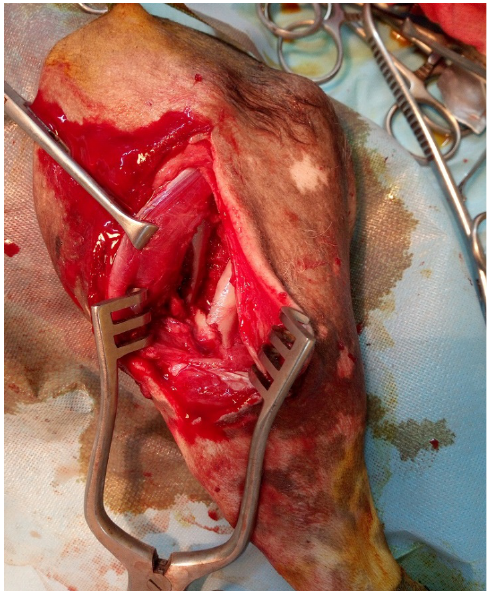
Fig. 2. Multiple fracture with 3 segments of femur bone that were proximal, middle, and distal segments